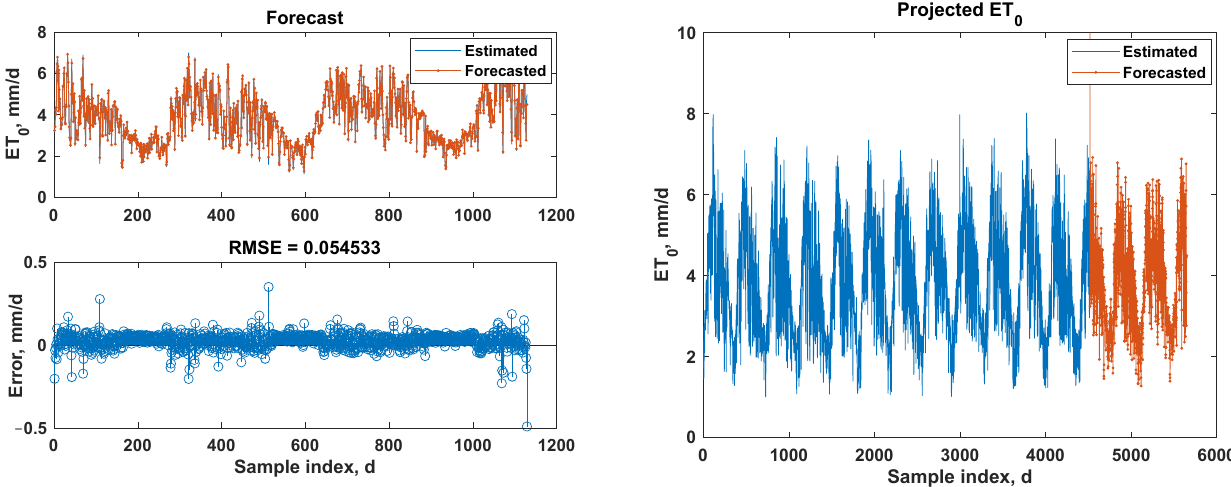
Figure 9. FAO-56 PM-calculated and Bi-LSTM-projected ET 0 values with error plots computed on the test dataset.